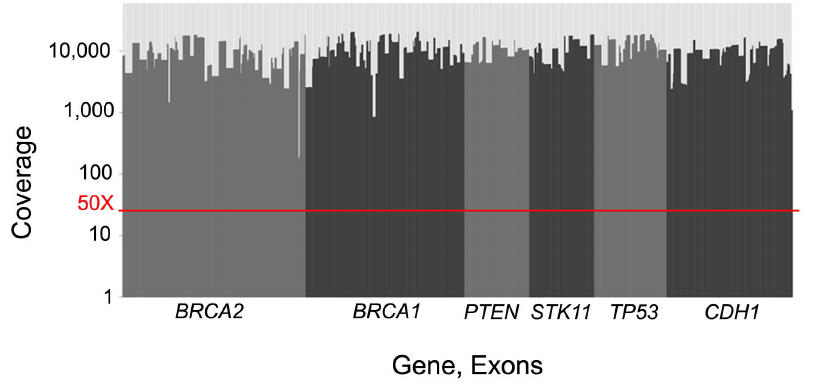
Figure 5. Average depth of coverage for each exon on the test from 3,000 representative samples. The red line indicates the 50X coverage threshold in which any region with insufficient coverage would be Sanger sequenced.